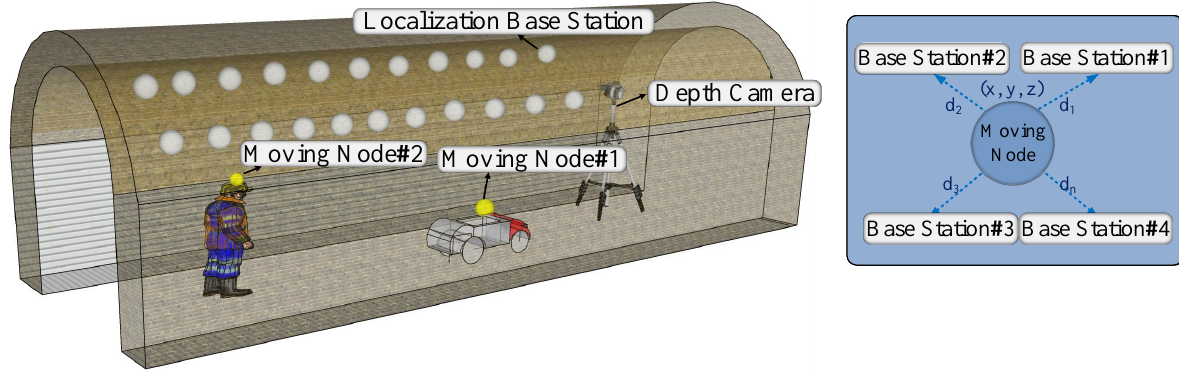
Figure 1. MineBL